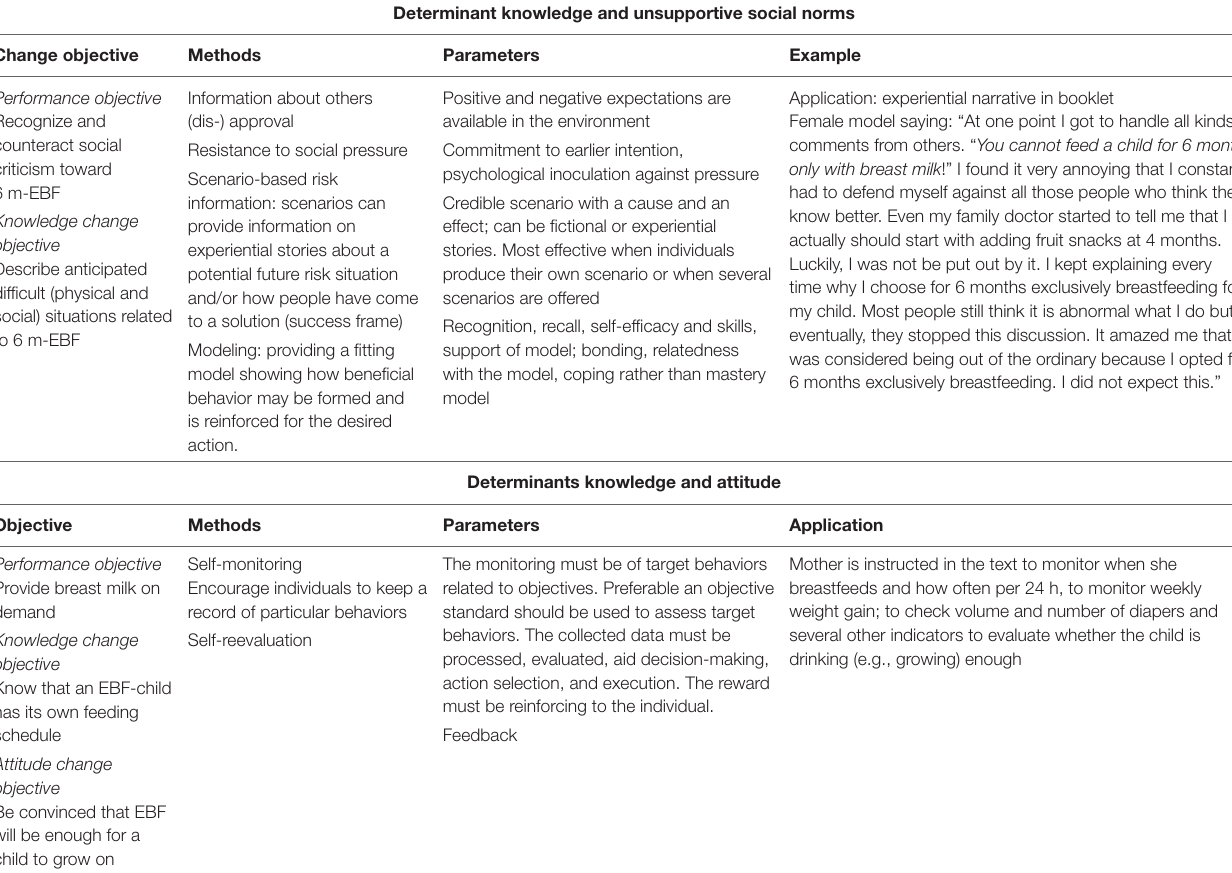
tABlE 3 | Examples of objectives and methods for changing